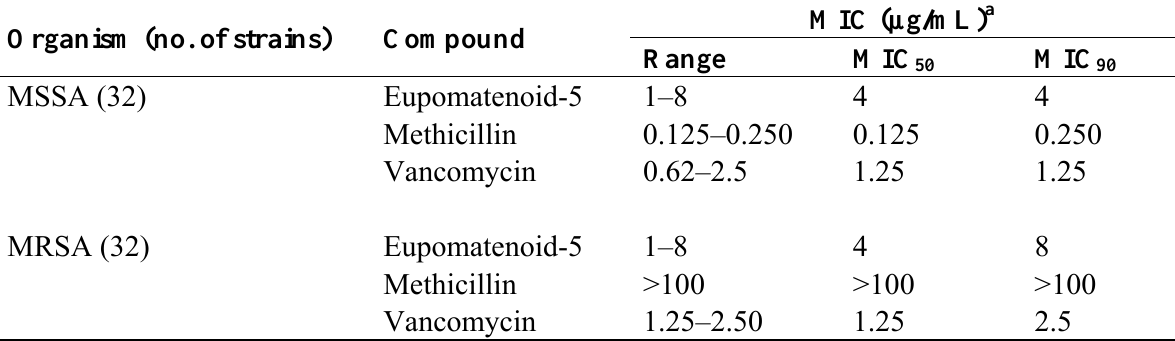
Table 2. Antibacterial activities of eupomatenoid-5 and reference antibiotic against methicillin-resistant (MRSA) and –susceptible Staphylococcus aureus (MSSA).